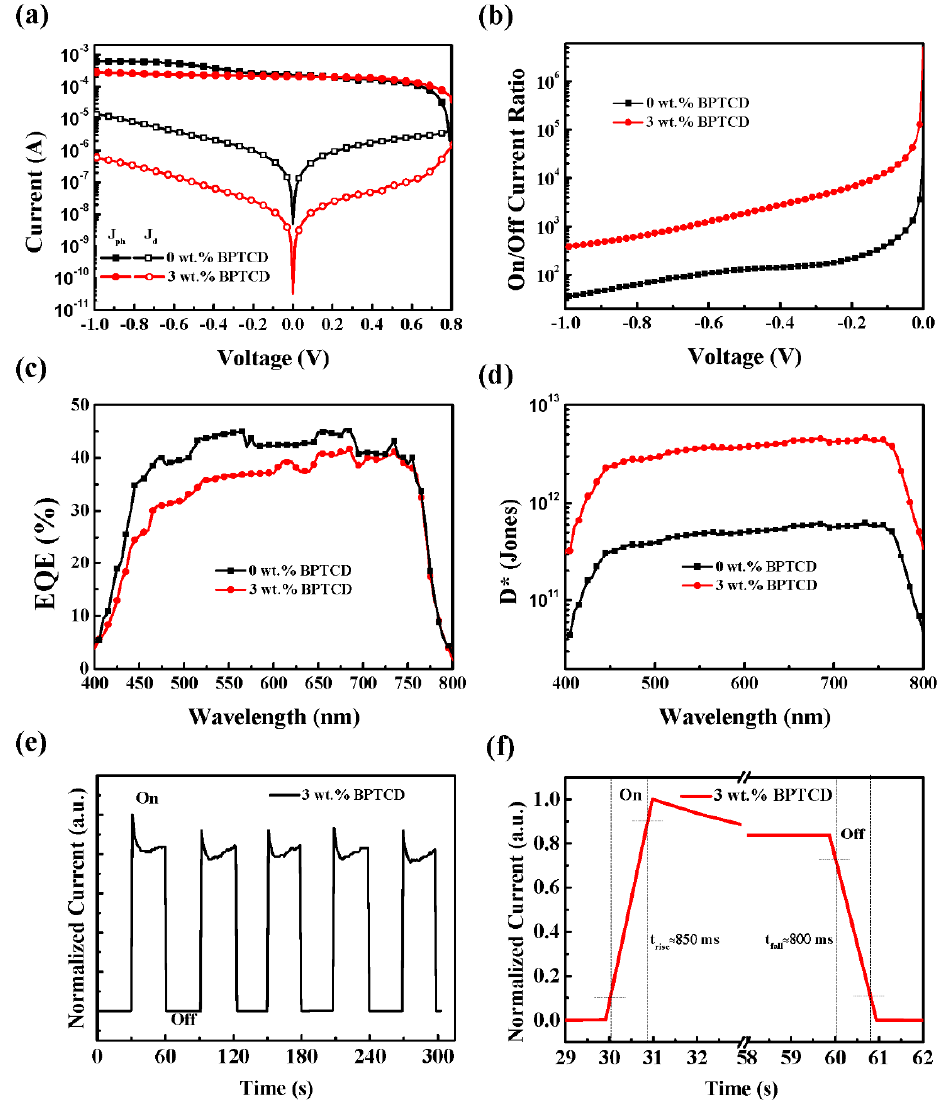
Figure 2. Electrical properties of PePDs with pure perovskite film and 3 wt.% BPTCD added perovskite film. ( a ) Semi-log I-V characteristics under light and dark condition; ( b ) On/off current ration; ( c ) Measured EQE spectra and ( d ) calculated D* values at − 0.1 V; ( e ) Dynamic photo response measurements of PePDs with 3 wt.% BPTCD by multiple cycles introducing and removal white light (intensity of 100 mW/cm 2 ); ( f ) Temporal photo-response of the PePDs with 3 wt.% BPTCD. Table 1. Summarization of the I d , I ph and on/off ratio of the PePDs at − 0.5 V, and D* at 685 nm.